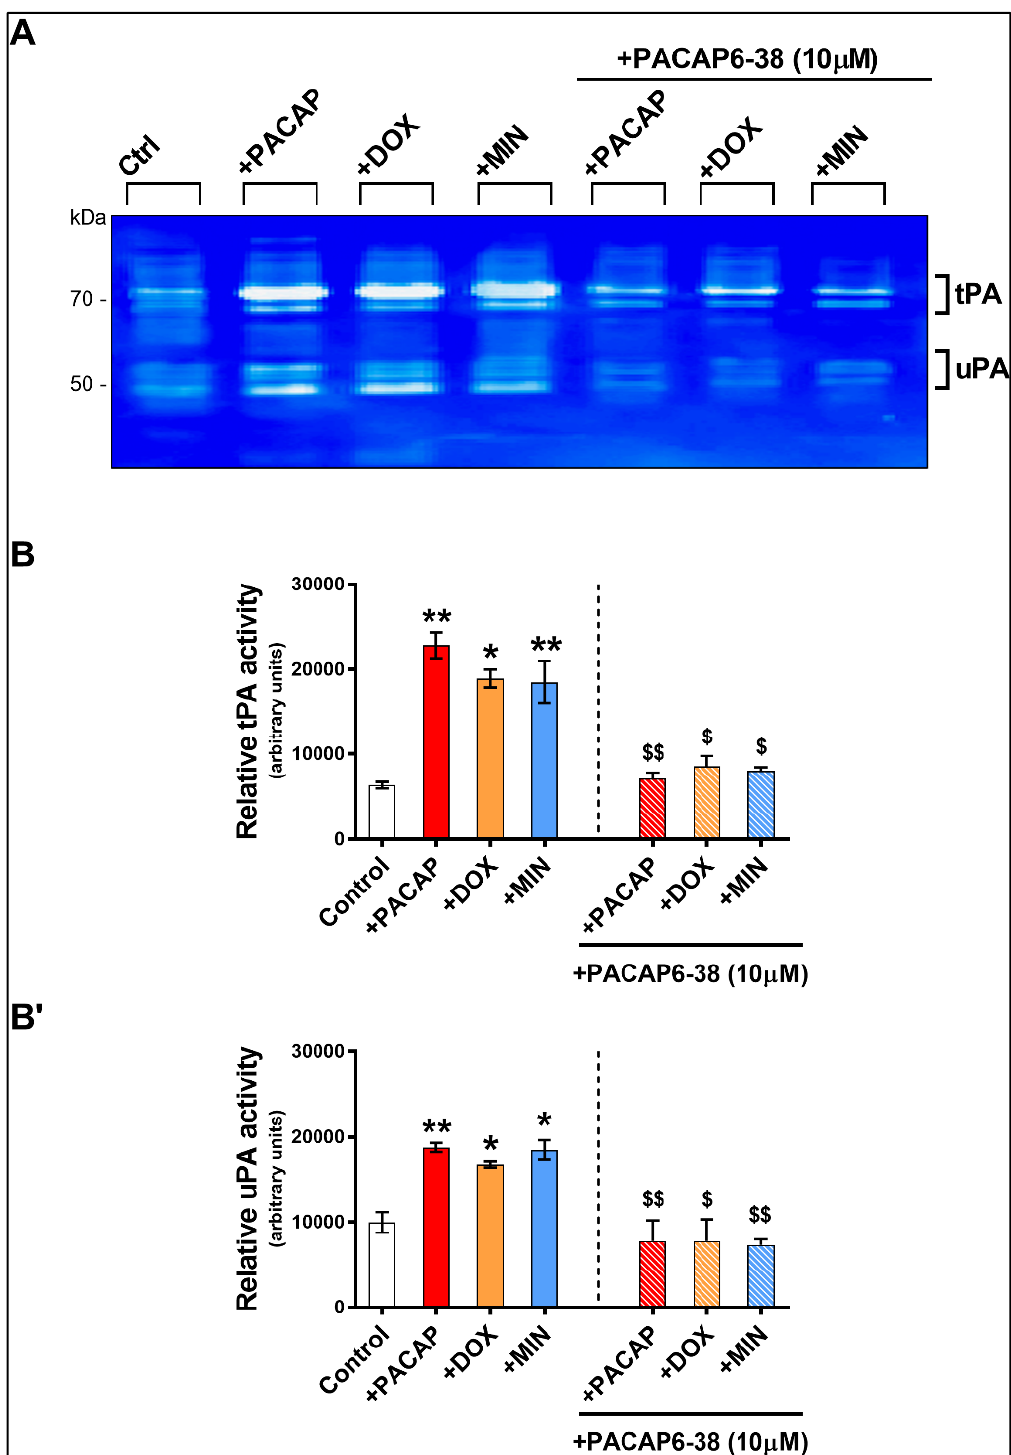
Figure 5. Zymographic assessment of tPA and uPA activity of RT4 cells in response to PACAP, doxycycline or minocycline with and without PACAP6-38 pre-treatment. ( A ) Representative zymogram and densitometric analyses showing the relative levels of tPA ( B ) and uPA ( B’ ). Cells were treated with either PACAP, doxycycline or minocycline only or pre-treated for 1 h with PACAP6-38 and then assessed after 24 h. Values reported (arbitrary units) are the mean ± S.E.M. of two separate experiments, each run using four separate batches of cells (n = 4 / group), measured using ImageJ software. * p < 0.05 or ** p < 0.01 vs. Control; $ p < 0.05 or $$ p < 0.01 vs. corresponding drug-treatment groups, as determined by ANOVA followed by Sidak’s post-hoc test.